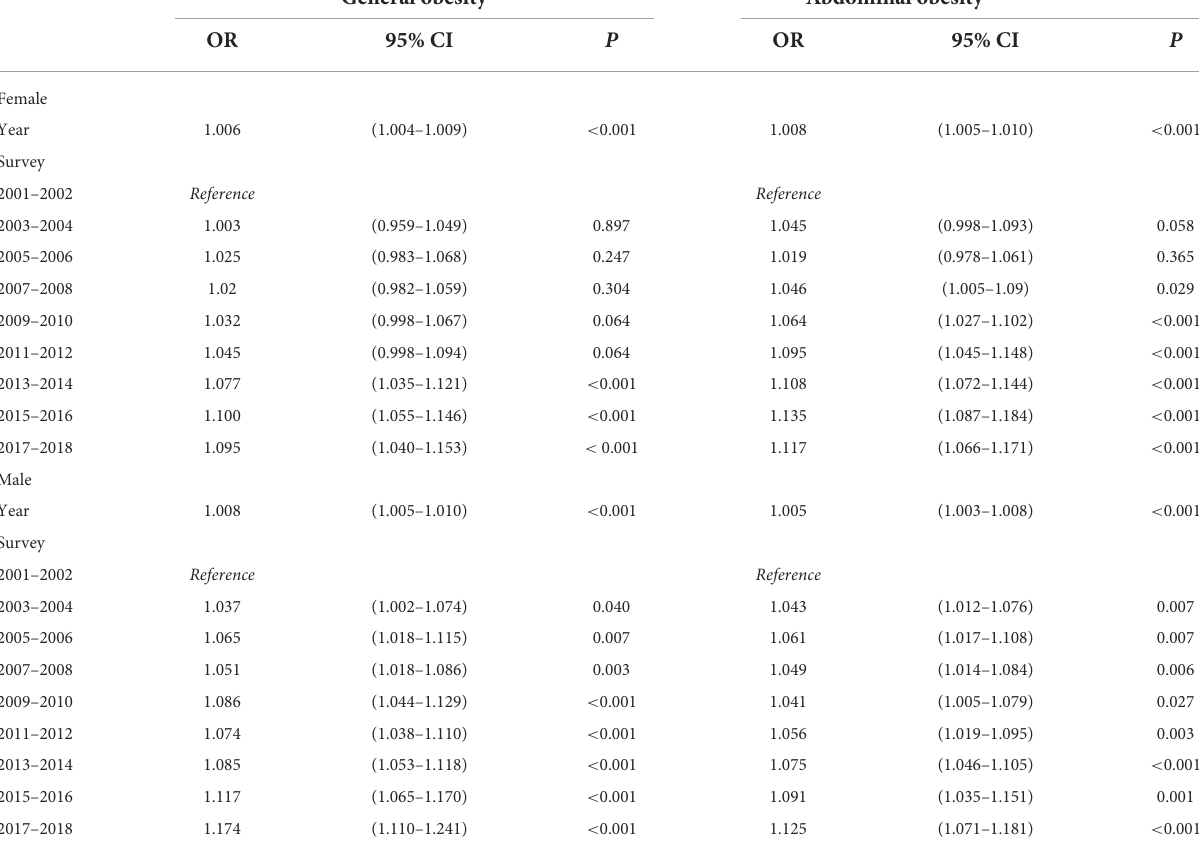
TABLE 2 Time-related change in the prevalence of obesity and abdominal obesity (weighted).